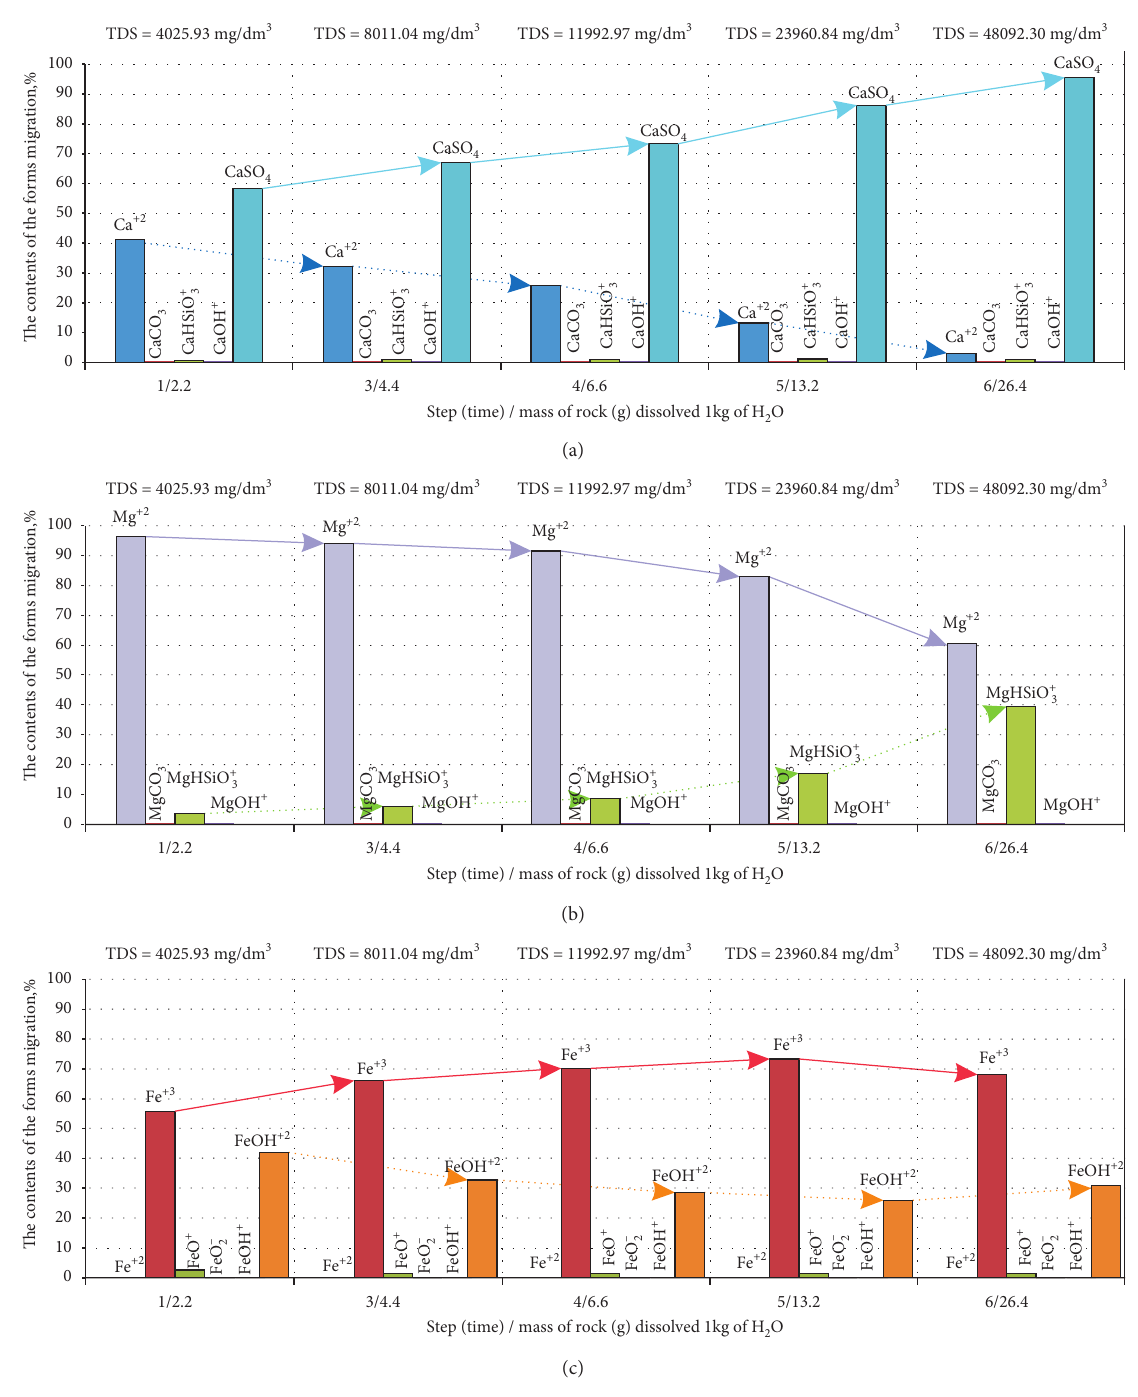
Figure 4: Inorganic migration of Ca (a), Mg (b), and Fe (c) in the waters of the “old” tailings